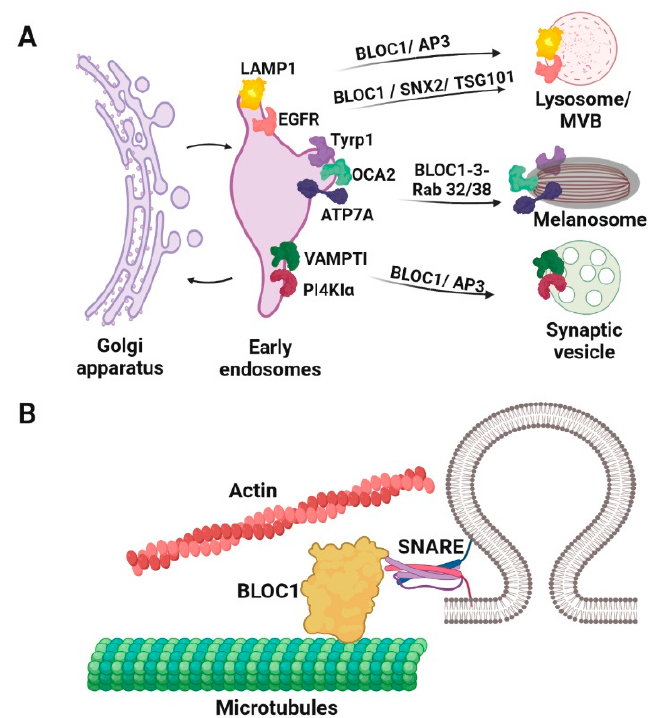
Figure 5. BLOC 1–3 sorts different cargoes to lysosomes and LROs. ( A ). BLOC1 and AP3 are involved in sorting different cargoes from early endosomes, including LAMP1 to the lysosomes as well as VAMP7-TI and PI4KII α to synaptic vesicles in neuronal cells. Guanine-nucleotide exchange factor (GEF) activity of BLOC3 for Rab32 and Rab38 GTPases is required for TYRP1, OCA2 and ATP7A cargo delivery from the early endosomes to mature melanosomes. ( B ). BLOC1 is associated with SNARE complexes, microtubules and the actin cytoskeleton.